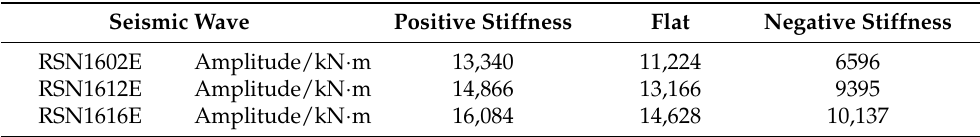
Figure 24. Time-history curve of pier bottom bending moment under the action of near-site vibration. Table 3. Bending moment amplitude and damping rate of pier bottom under near-site vibration.